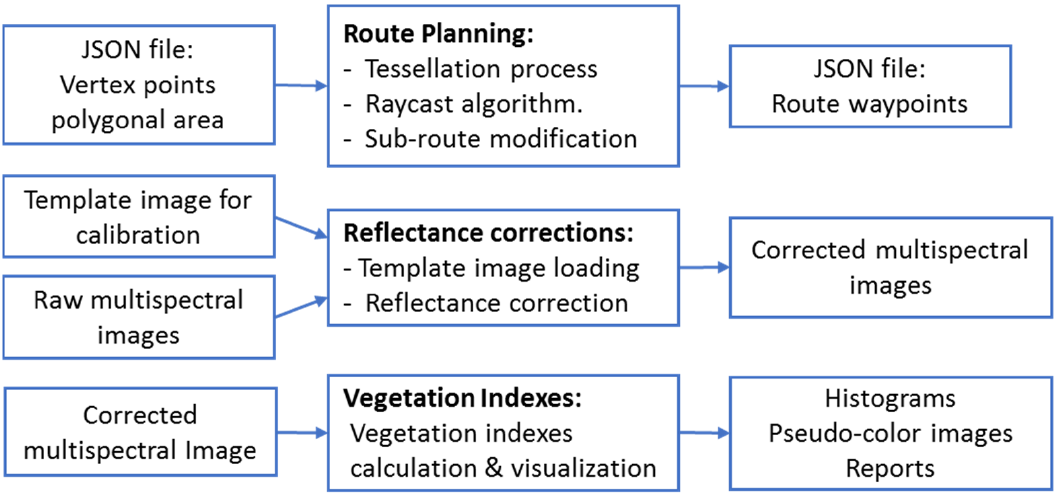
Figure 3. The main MATLAB compiled modules within the application framework.